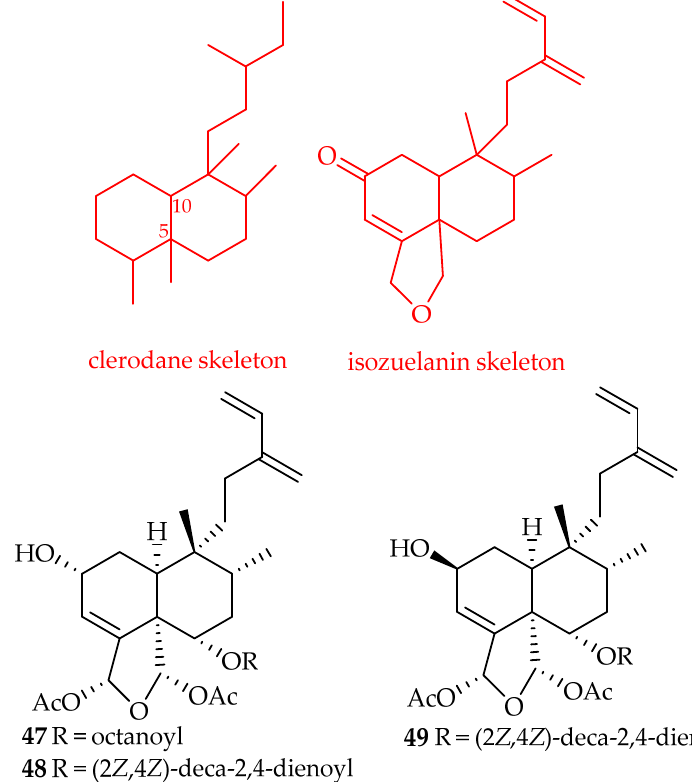
Figure 20. Structure of corymbulosins D–F 47–49